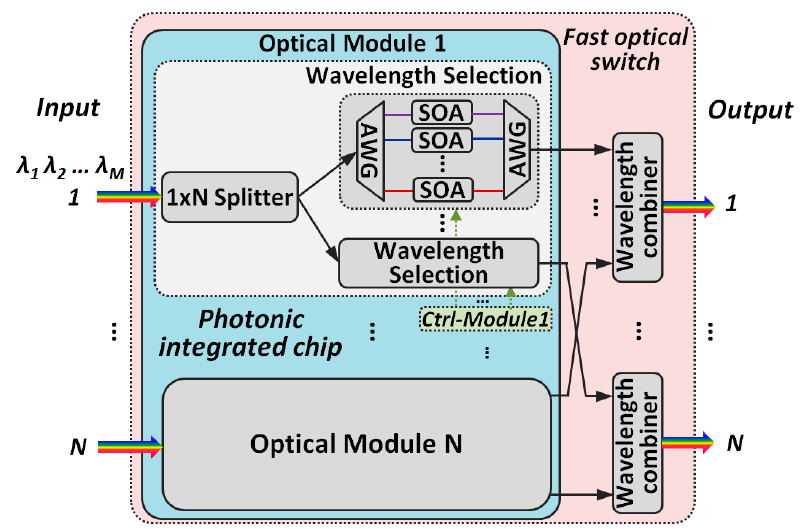
Figure 3. Schematic of the WDM cross-connect based on Semiconductor Optical Amplifiers (SOAs).